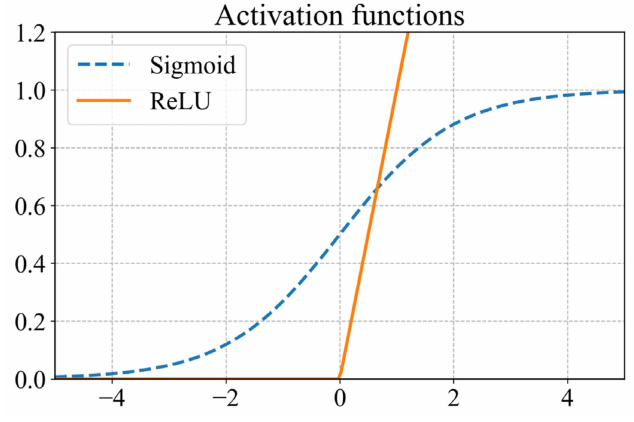
Figure 6. Plot illustrating the sigmoid and ReLU activation